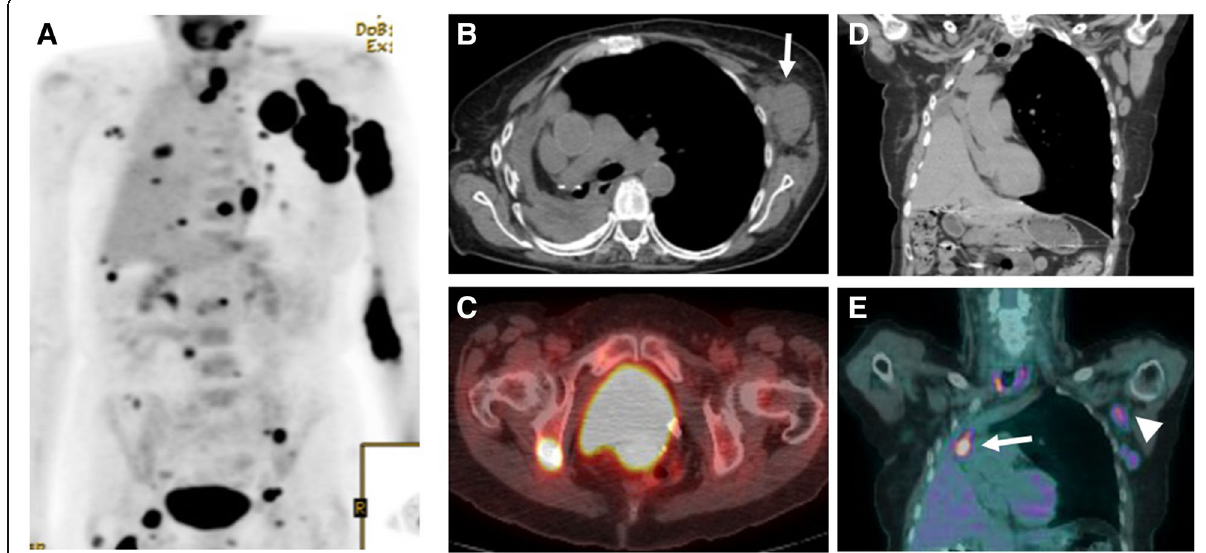
Fig. 8 A 71-year-old woman with history of non-small cell lung cancer treated with pneumonectomy and erlotinib and grade I follicular lymphoma treated with chemotherapy presenting with new left arm swelling and a left axillary mass. a Coronal MIP reconstructed PET image shows multiple FDG avid left axillary adenopathy with SUVmax of 33.4, and scattered FDG avid foci in the left arm, within the chest and abdomen. b Axial CT image showed a large axillary adenopathy (arrow). c PET-CT fused axial image shows an area of FDG uptake within the left ischium. The left axillary adenopathy and the ischiatic lesion were biopsied and were consistent with large B cell lymphoma. d Coronal